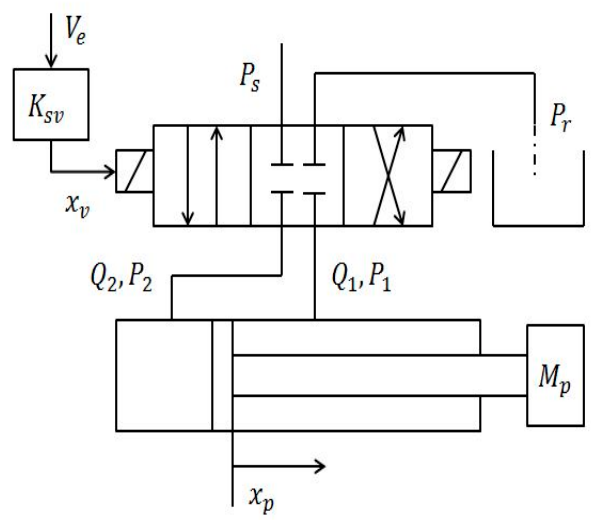
Figure A1. Schematic of Hydraulic Actuator.